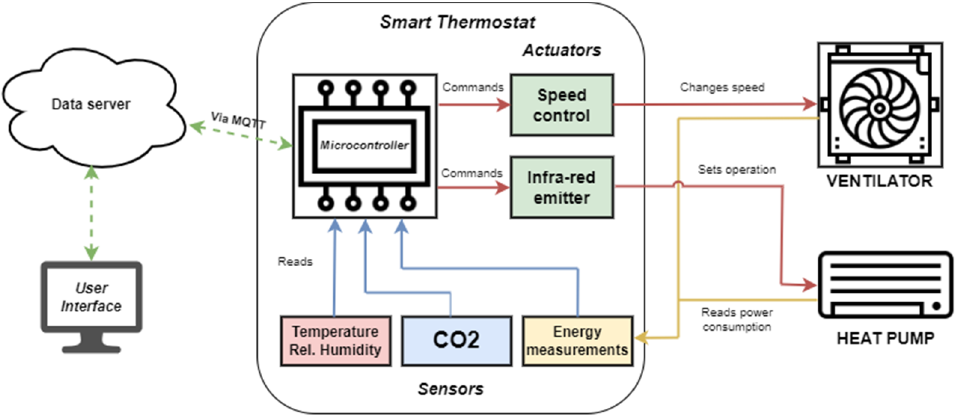
Figure 1. Diagram showing the smart thermostat